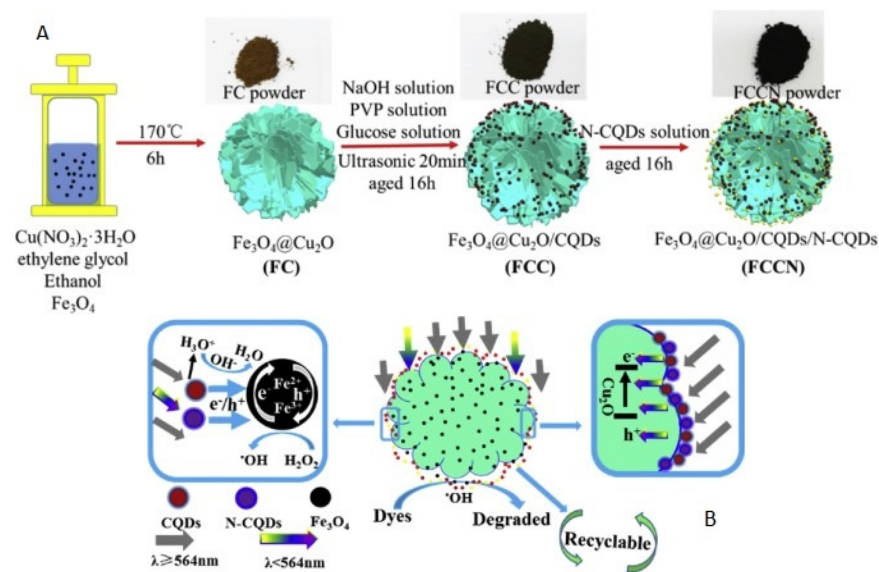
Figure 7. ( A ) Schematic illustration of the synthesis of FCCN. ( B ) Schematic diagram of the catalytic mechanism of FCCN (see text). Reprinted with permission from Ref. [91]. Copyright 2020, Elsevier. Table 3. Summary of recently used Fe–Cu oxides composites as photo–Fenton photocatalysts in wastewater treatment.